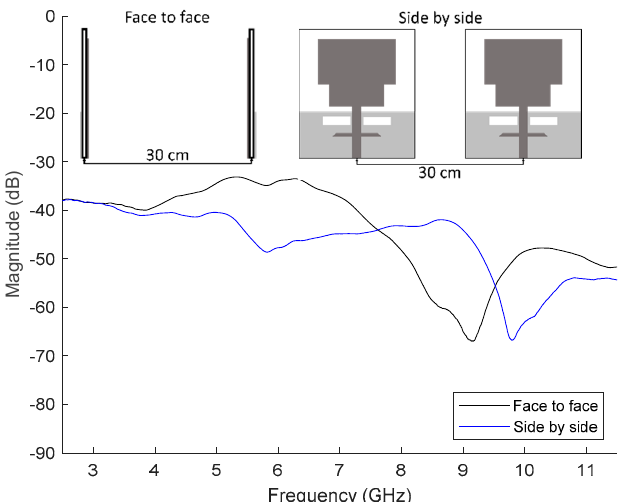
Figure 13. Results of the transmission parameter for face-to-face and side-by-side setup configura- tions.